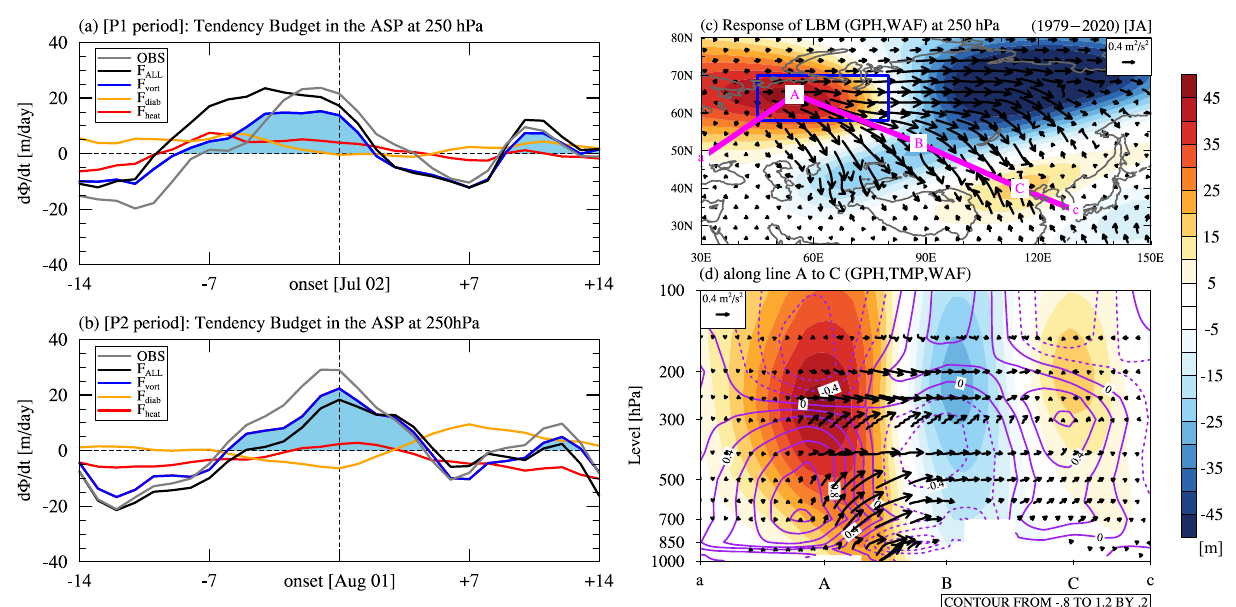
Figure 4. Quasi-geostrophic geopotential tendency (QG tendency) budget analysis and model experiments. Time series of the 7-day running mean QG tendency budget (units: m/day) in the ASP at 250 hPa for ( a ) P1 and ( b ) P2 periods. The solid gray line indicates the geopotential height (GPH) tendency obtained from reanalysis data. Black, red, orange, and solid blue lines indicate the QG tendency budget induced by the total forcing (F ALL ), temperature advection (F heat ), diabatic heating (F diab ), and vorticity forcing (F vort ), respectively. The shading in ( a ) and ( b ) indicates a positive vorticity forcing period. ( c and d ) Same as in Fig. 3a and b but for the atmospheric responses to the vorticity tendency and diabatic heating (Q1) forcings in the linear baroclinic model (LBM) experiment. These steady forcings in the LBM are derived from the daily relative vorticity tendency and Q1 over the Arctic-Siberian Plain (ASP) region from the surface level to 10 hPa with a temporal average from days − 3 to 0 (onset) during the P1 and P2 periods in ( a ) and ( b